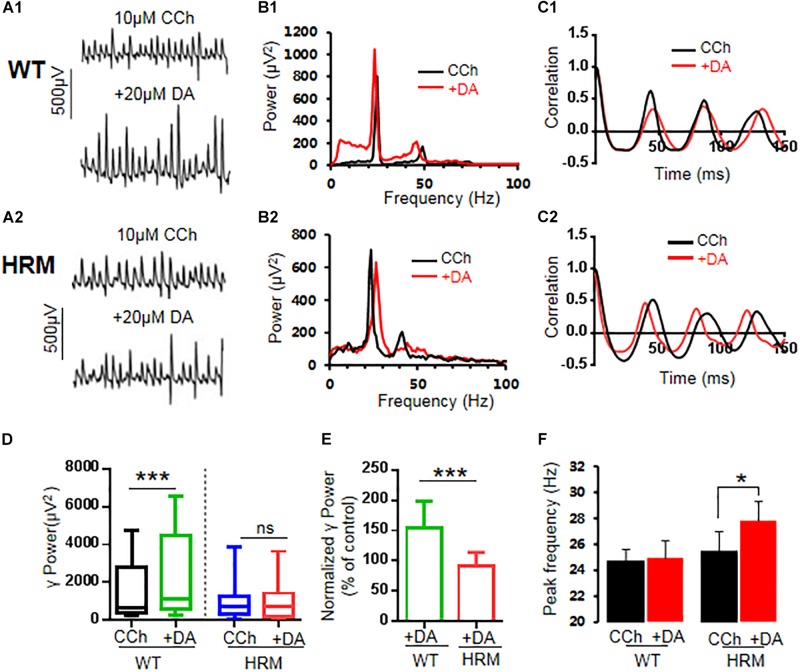
Effect of dopamine (DA) on γ oscillations in slices of hippocampal CA3 from wild-type mice (WTM) and heterozygous reeler mice (HRM). The original curve of 1-s field potential before and after application of DA (20 μM) recorded in slices of hippocampal CA3 region from WTM (A1) and HRM (A2). (B1,B2) The power spectrum of field potential before and after application of DA (20 μM) from WTM (B1) and HRM (B2) hippocampal slices. (C1,C2) Autocorrelograms of the recording in A1 and A2 show the effects of DA on oscillation regularity from WTM (C1) and HRM (C2). (D) The bar graph shows the effects of carbachol (CCh) and CCh + DA on γ power in WTM and HRM (***P < 0.001). (E) The bar graph shows the effects of DA (CCh + DA) on normalized γ power (percentage change over control) in WTM and HRM (***P < 0.001). (F) The bar graph shows peak frequency of the oscillatory activity in WTM and HRM (*P < 0.05).